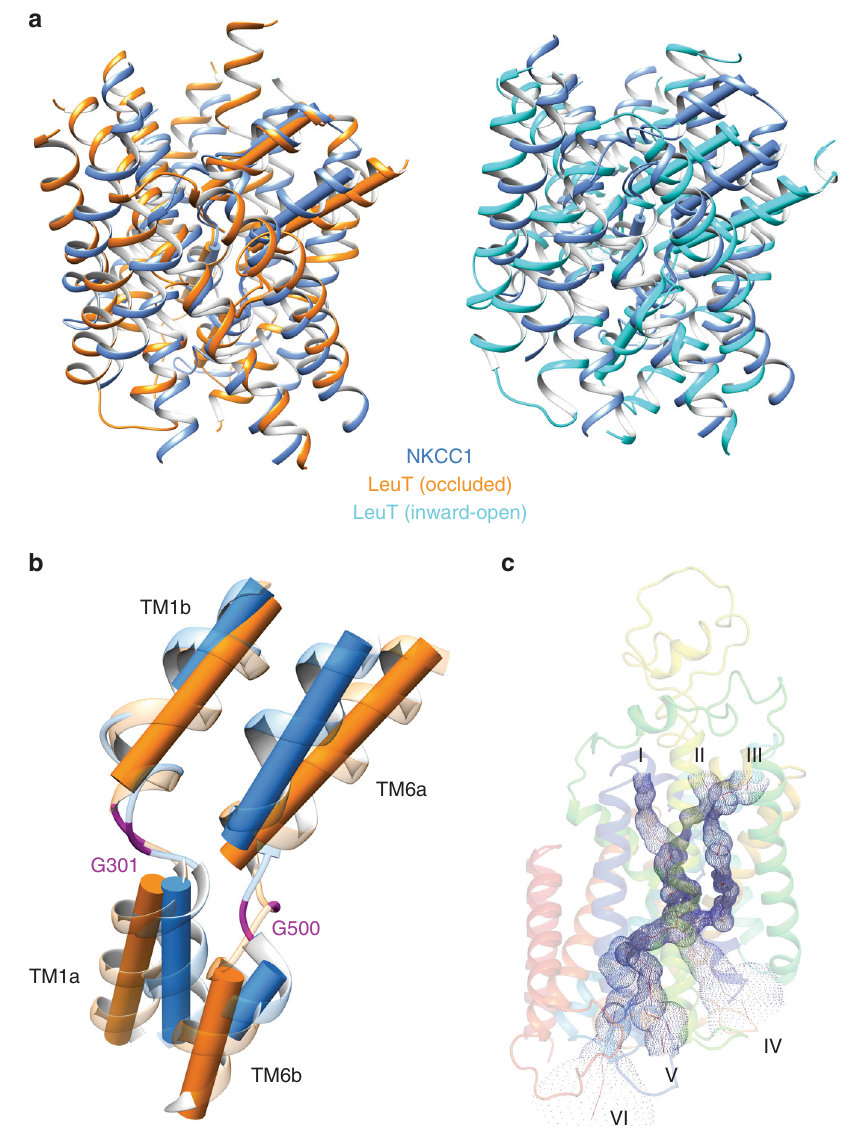
Fig. 3 NKCC1 structure in an inward-open state. a Superimposition of the fi rst ten TM helices of human NKCC1 with those of LeuT in occluded state (left) or in inward-open state (right). Structures are shown in ribbon diagram. TM1 and TM6 helices, which undergo signi fi cant conformational changes among different transport states, are also depicted as cylinders. b Comparison of TM1 and TM6 helices in NKCC1 and LeuT (occluded). The glycine residues in the fl exible hinge regions are highlighted with magenta color. c Solvent accessible pathways in NKCC1 are mapped with HOLE. Three entryways, three exits, and central cavity are outlined with blue